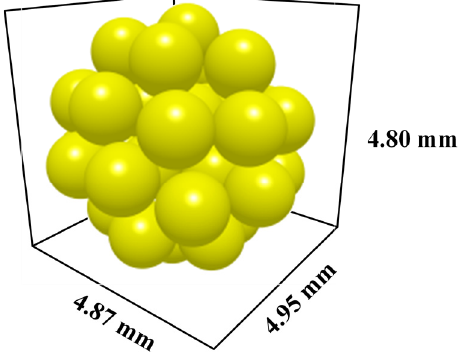
Figure 3. Size and shape of the DEM particles used in the simulations.